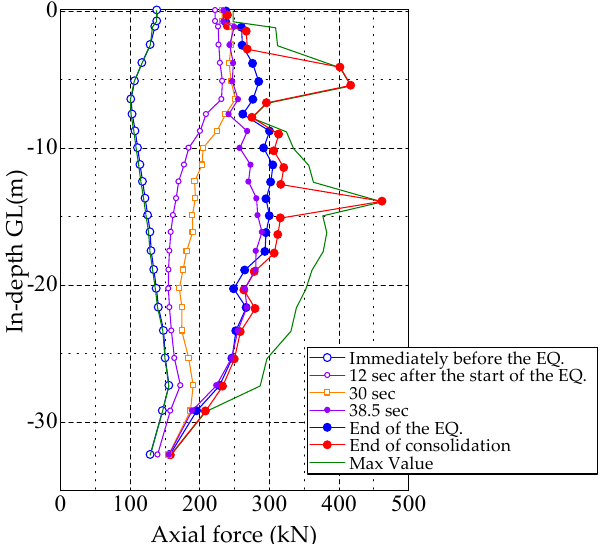
Figure 18. Changes in axial force distribution of pile over time: seismic motion (A).